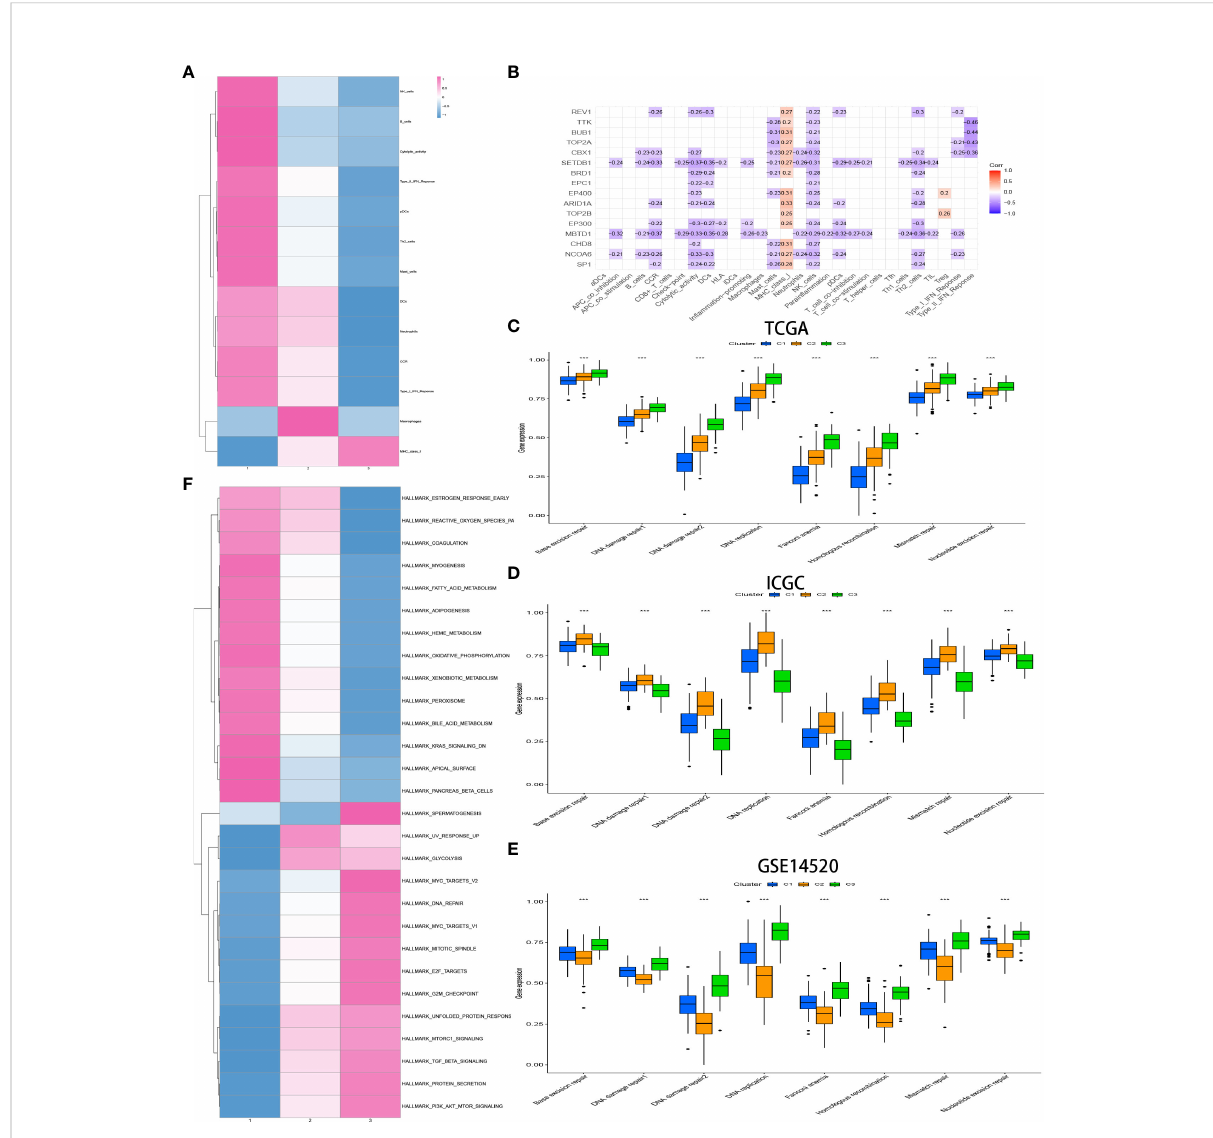
FIGURE 4 Heatmap of immune responses among the CR clusters (A) . Analysis of the hub genes – immune response relationships of HCC based on TCGA data (B) . Exploration of the difference in DNA damage repair pathways among CR clusters in the TCGA (C) and ICGC (D) cohorts and GSE14520 (E) by ssGSEA analysis. GSVA enrichment analysis exhibits the activation status of biological pathways among different CR clusters (Kruskal – Wallis test, P < 0.05), with red representing activation and blue representing inhibition (F) .